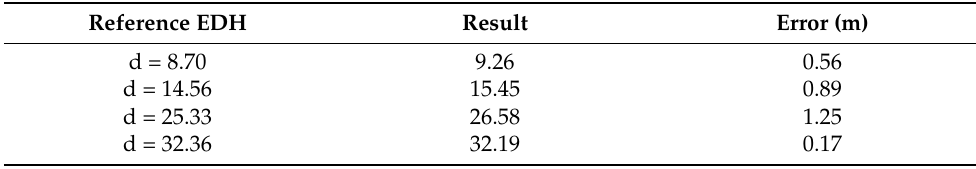
Table 3. Results of joint inversion